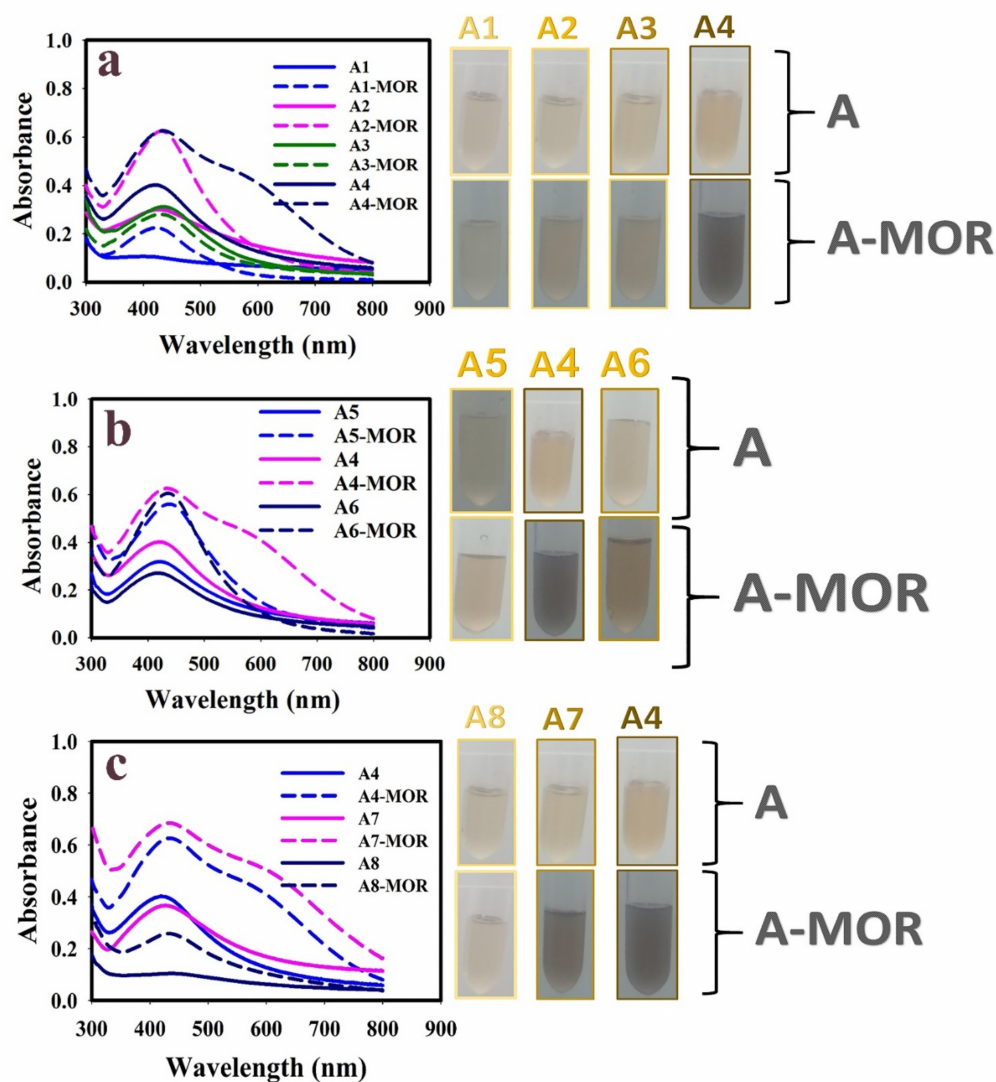
Figure 1. UV-vis spectra of the Au@Ag NPs synthesized under different conditions; ( a ) type of additive, ( b ) acoustic intensity, and ( c ) reaction